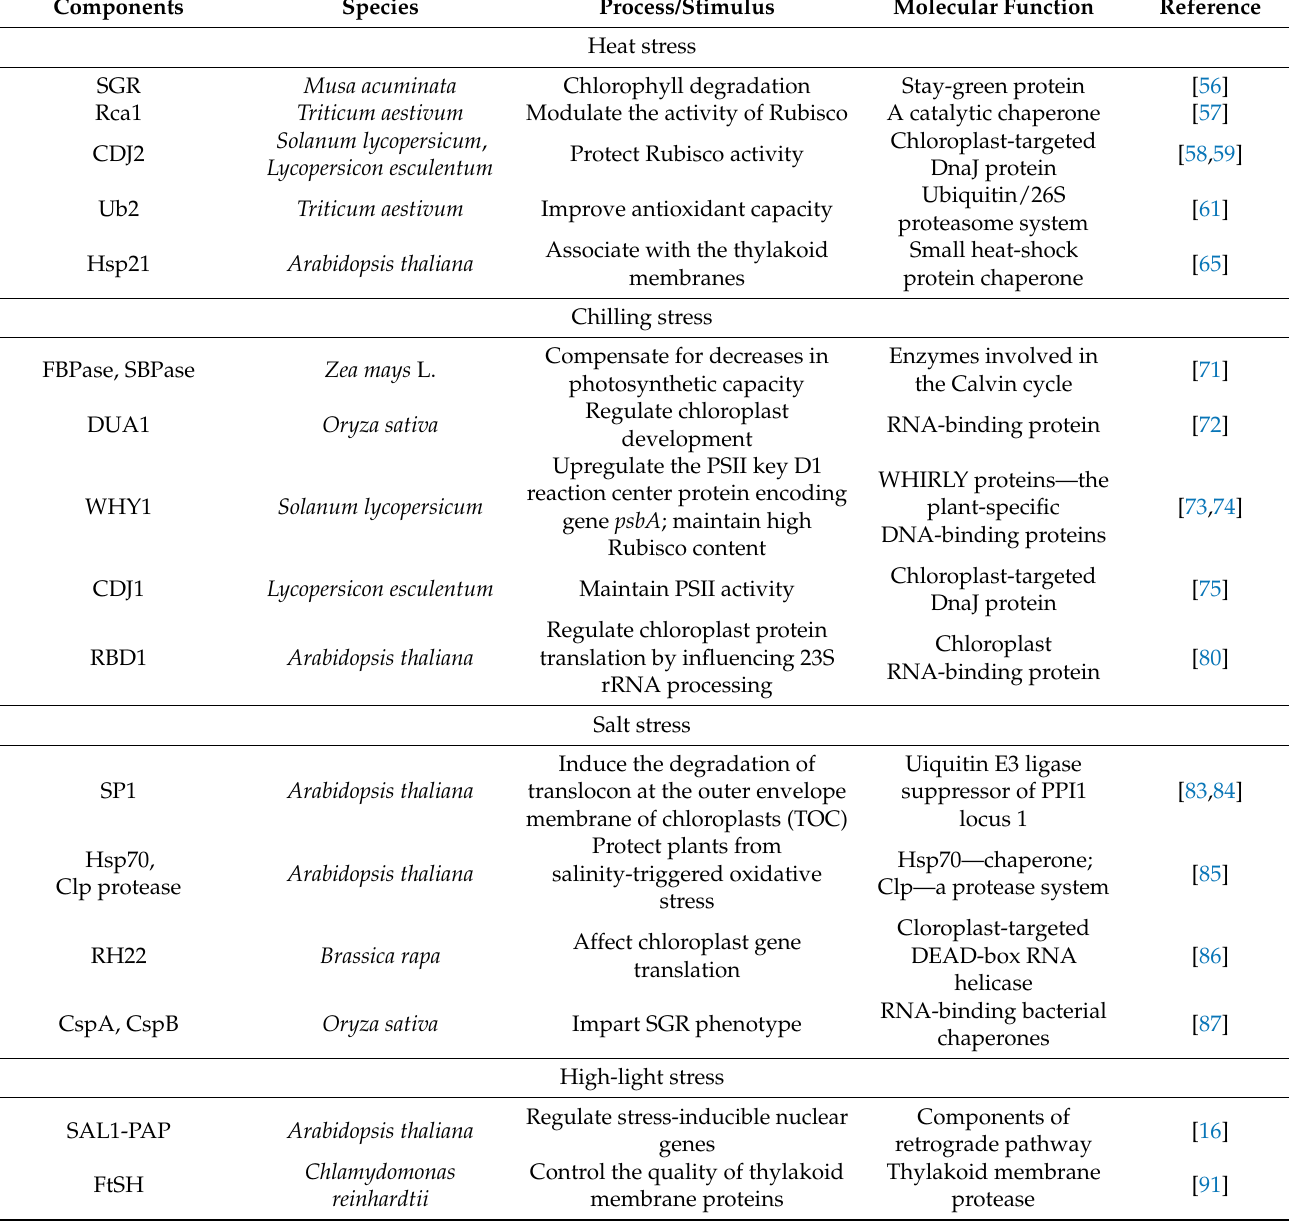
Table 1. Summary of known chloroplast biological processes involved in plant stress